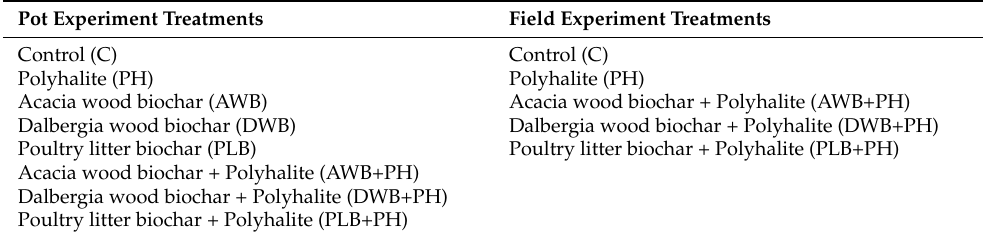
Table 2. Treatments of pot and field experiments along with their abbreviations. Pot Experiment